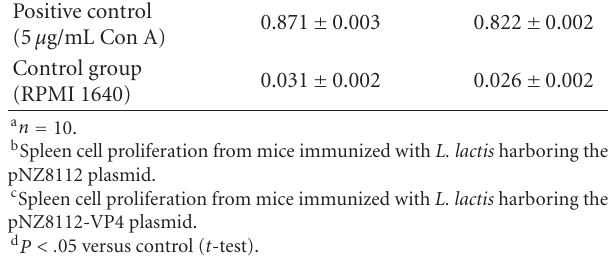
Figure 4: Specific anti-VP4 IgG in serum response after oral immu- nization. Mice were orally immunized with 10 9 CFU of pNZ8112- VP4/NZ9000 and pNZ8112-VP4/NZ9000, and the immune proto- col was administered on three consecutive days: the inoculation at days 0, 1, and 2; a booster at days 14, 15, and 16; a second booster at days 28, 29, and 30. Mice sera were collected on days 0, 9, 25, and 41 following the first immunization. Sera samples were analyzed for the presence of IgG-specific VP4 antibodies by ELISA. The OD value of each well represents a mixture of two serum samples; the bars represent IgG mean OD values in four wells representative of eight samples, which were detected at di ff erent time points for each group.